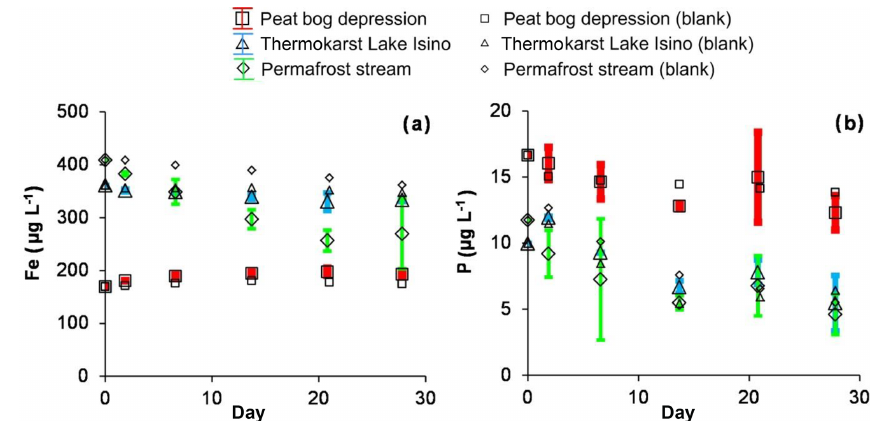
Figure 5. Fe (a) and P (b) concentrations over time in photodegradation experiments. The error bars are ± 1SD of the